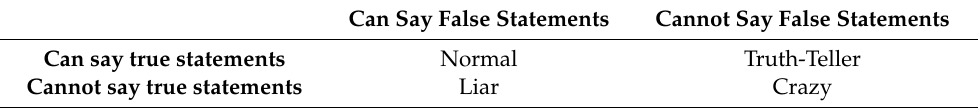
Table 2. Type of people and their possible statements by their truth value in our